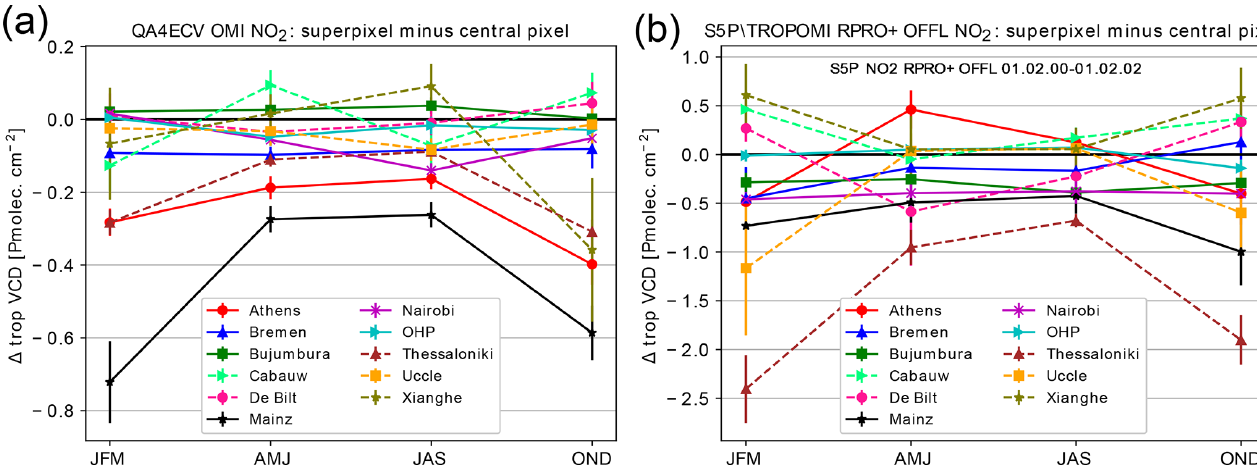
Figure 8. (a) Mean difference for each season between the QA4ECV OMI superpixel (ground pixels averaged within 20km of the central site) and the central OMI ground pixel using data from 2004 to 2016. (b) Similar to (a) but using TROPOMI NO 2 data from April 2018 to May 2019, and the superpixel is defined within a latitude, longitude box of (cid:49) lat = 0 . 14 ◦ , (cid:49) long = 0 . 7 ◦ centred on the MAX-DOAS